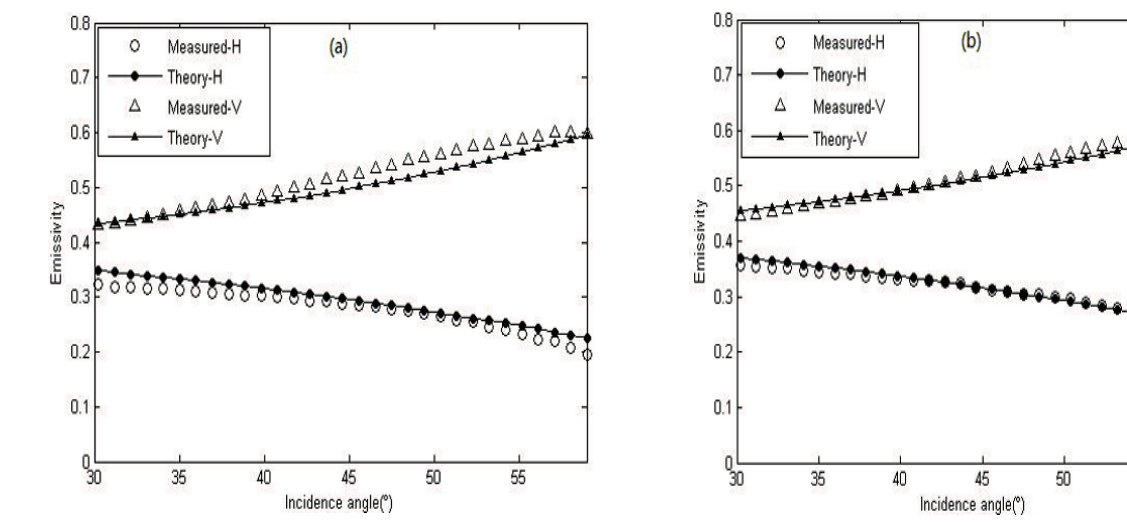
Figure 2. Measured and theoretical emissivities of foam-covered surface vs. incidence angle, where “Measured-H” and “Measured-V” are measured horizontal and vertical emissivities, respectively. Theoretical results of RM emissivity model are shown by “Theory-H” and “Theory-V”. For each panel, the SSS, SST, foam thickness d , and air volume fraction are listed in Table 2. ( a ) SSS = 31.23 psu, SST = 1.66 °C, d = 1.18 cm, AVF = 0.9161; ( b ) SSS = 31.71 psu, SST = 0.20 C